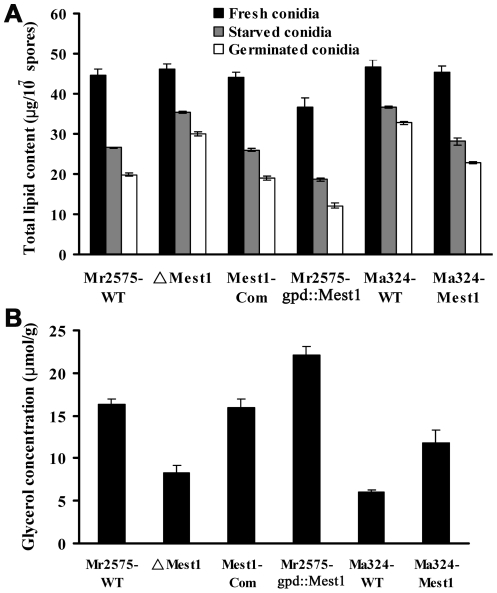
Determination of lipid content.(A) Lipid content in conidia freshly harvested from PDA plates (black bars), nutrient-stressed conidia soaked in water for 36 h (grey bars) and conidia germinated in 1% alanine for 12 h (white bars). (B) Glycerol content in the six strains grown for 48 h in BM plus 0.25 mg/ml Manduca cuticle lipids.